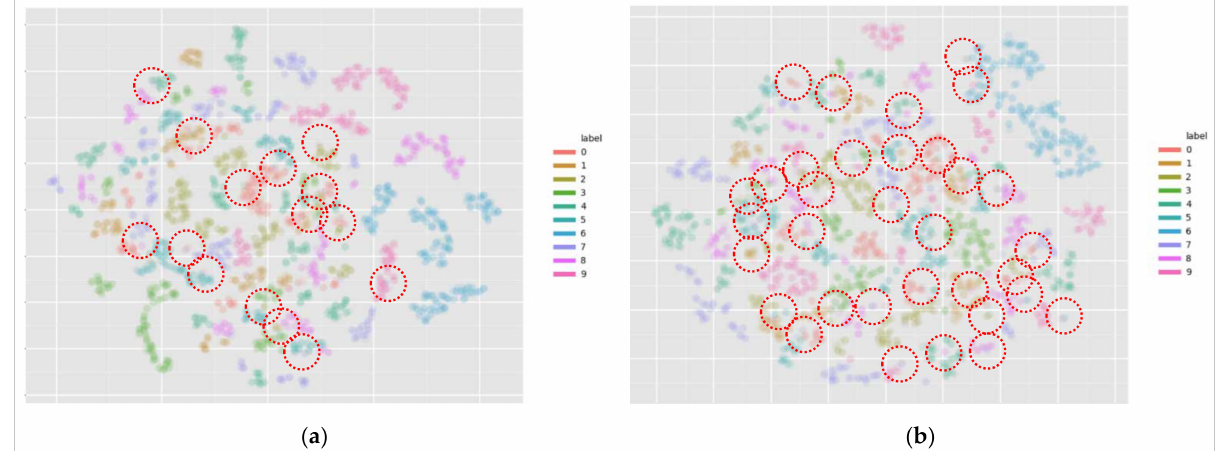
Figure 9. The comparison between 2D t-SNE of ( a ) D Peace circles. Best viewed in zoom .